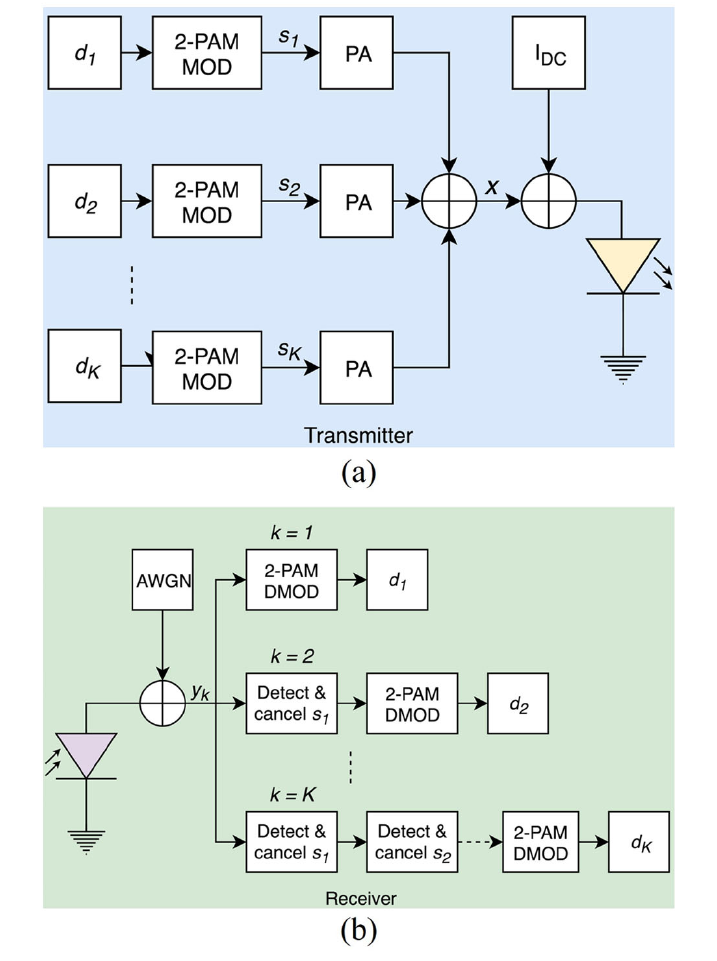
Figure 3. The concept of a NOMA-based VLC system: ( a ) Transmitter ( b )